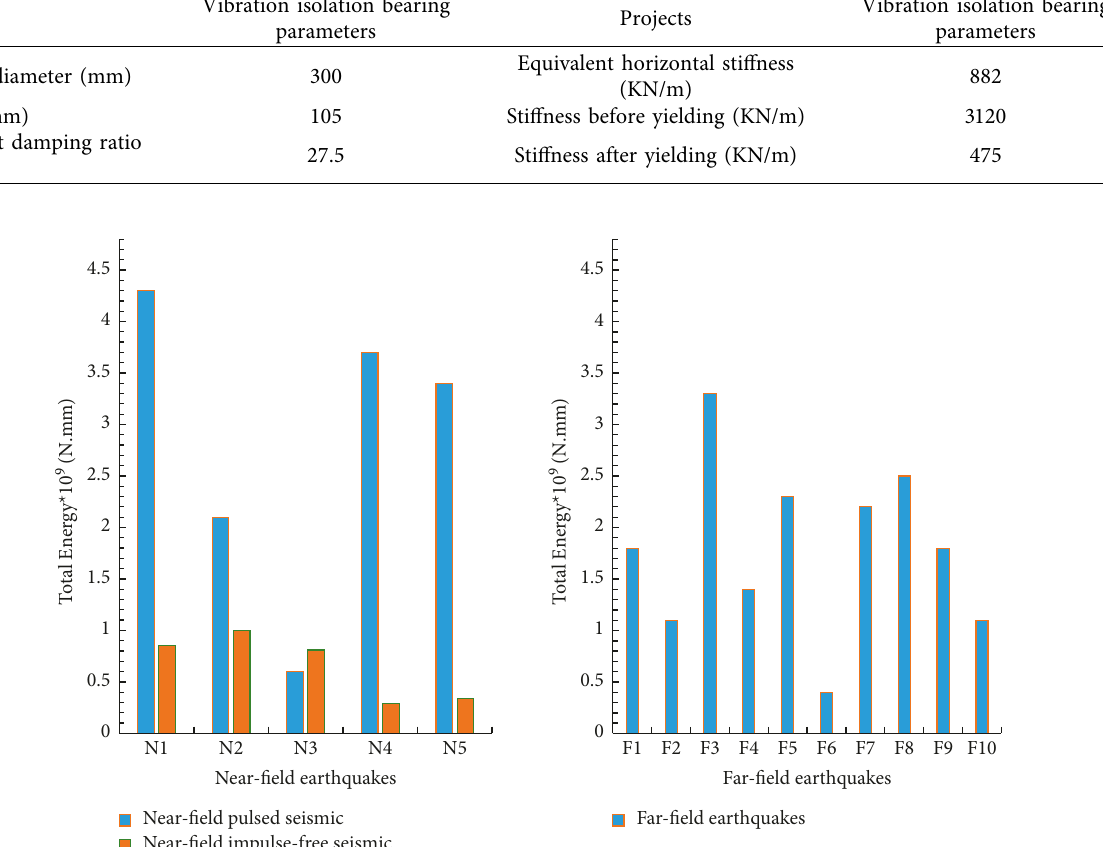
Figure 8: Earthquake energy